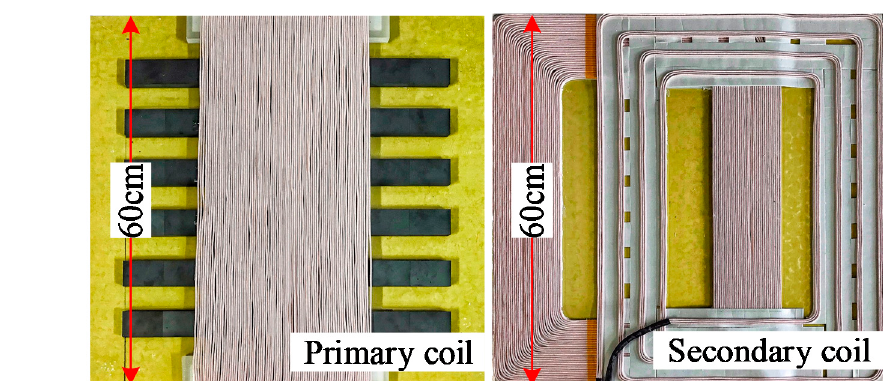
Figure 21. Transformer structure. Table 3. System key parameters.